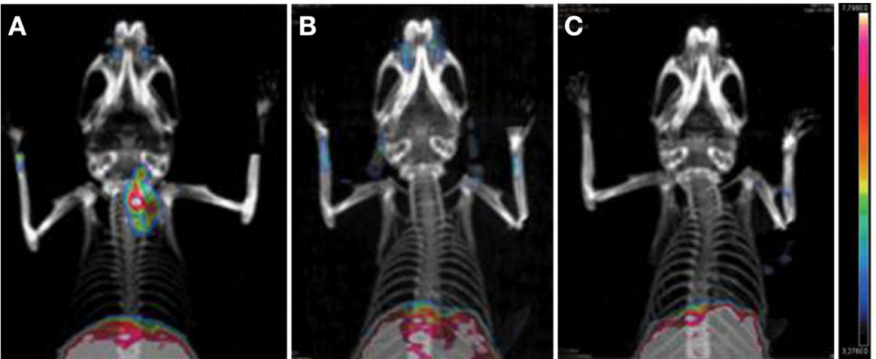
Figure 12. PET/CT images of mice at 24 h after intravenous injections. ( A ) Injection with 3 MBq of [ 89 Zr]Zr-DFO- α Gal3-Fab-PAS 200 . ( B ) Co-injection of 3 MBq of [ 89 Zr]Zr-DFO- α Gal3-Fab-PAS 200 and 1000-fold of nonradioactive aGal3-Fab-PAS 200 (for blocking). ( C ) Control. Color scale bars: 3.3–7.8%ID/g. Reproduced with permission from [139], copyright 2020 Mary Ann Liebert,